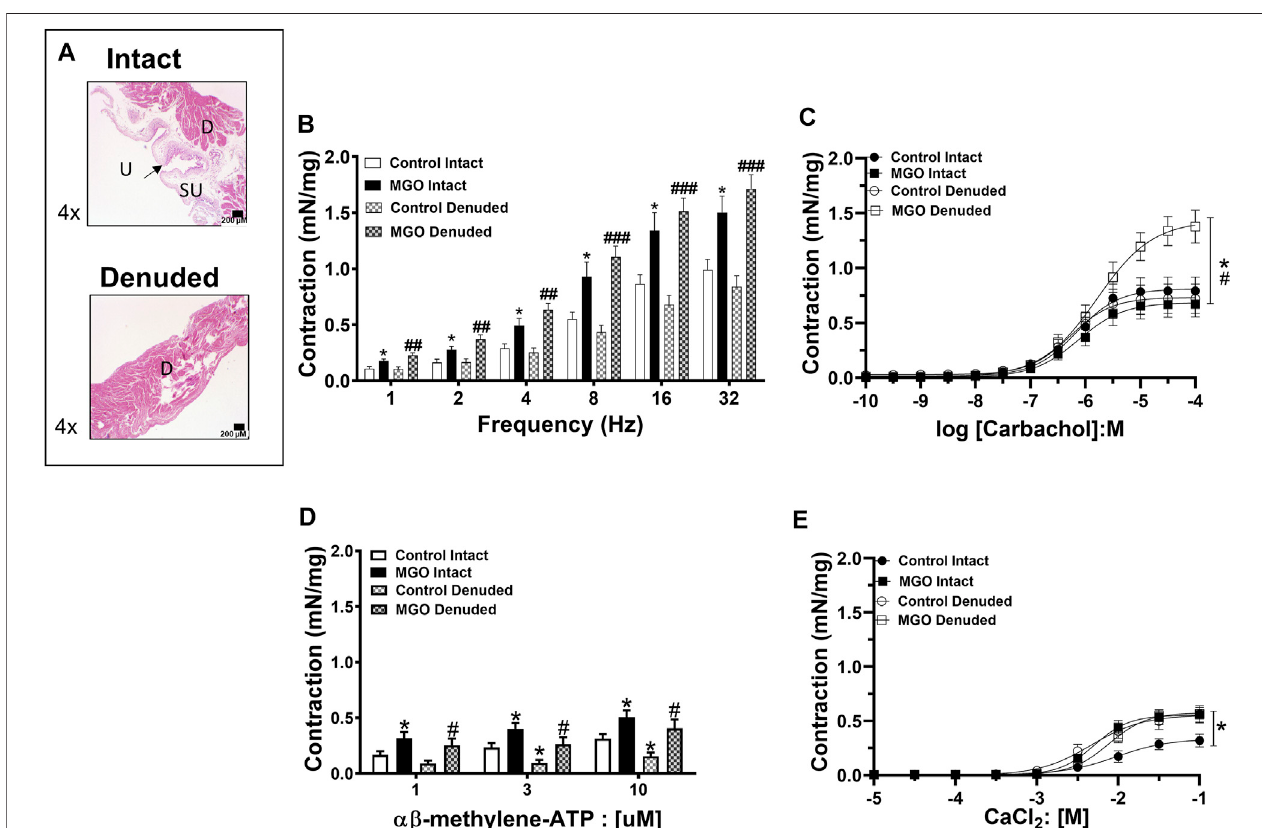
FIGURE 6 | The effects of methylglyoxal (MGO) treatment in intact and mucosa-denuded bladder contractions. Panel (A) shows representative images of intact bladders indicating the presence of urothelium, suburothelium and detrusor smooth muscle whereas in denuded bladder only the detrusor can be observed. Panels (B − E) show the contractions induced by electrical- fi eld stimulation (EFS; 1 – 32 Hz), carbachol (0.1 – 100 µM), α , β -methylene-ATP (1 – 10 µM) and extracellular Ca 2+ (10 μ M – 100 mM), respectively. Data are expressed as mean ± SEM (6 – 10 mice per group). * p < 0.05 compared with respective control-intact groups; # p <